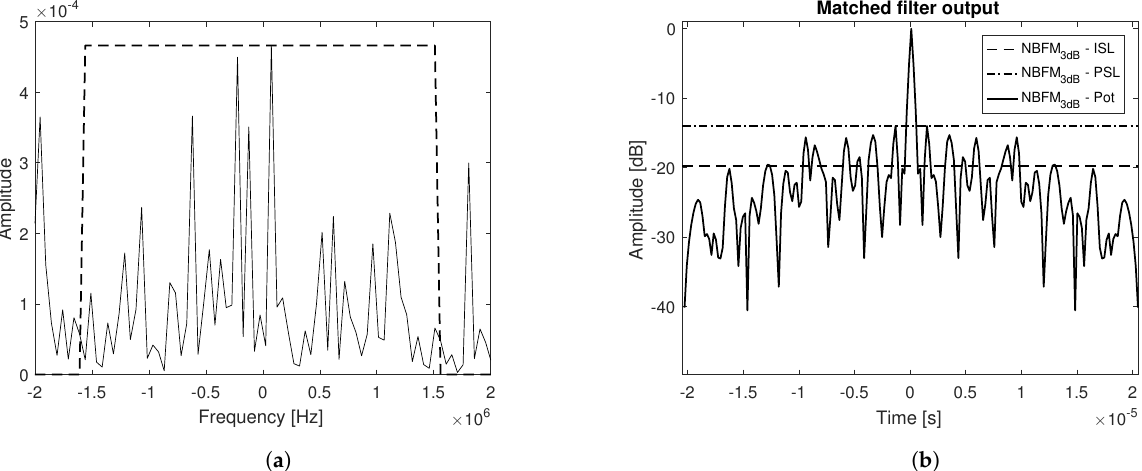
Figure 8. Power Spectral Density ( a ) and matched filter output power ( b ) of a pseudorandom narrowband frequency modulated signal realization (NBFM 3dB )— B ˜ s = 3 MHz, τ s = 20.48 µ